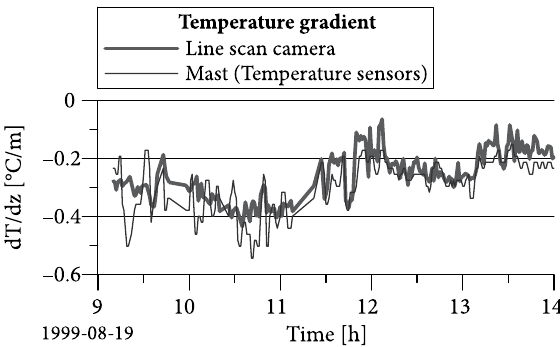
Fig. 4. Temperature gradient measurements versus temperature gradients derived from image processing (Flach